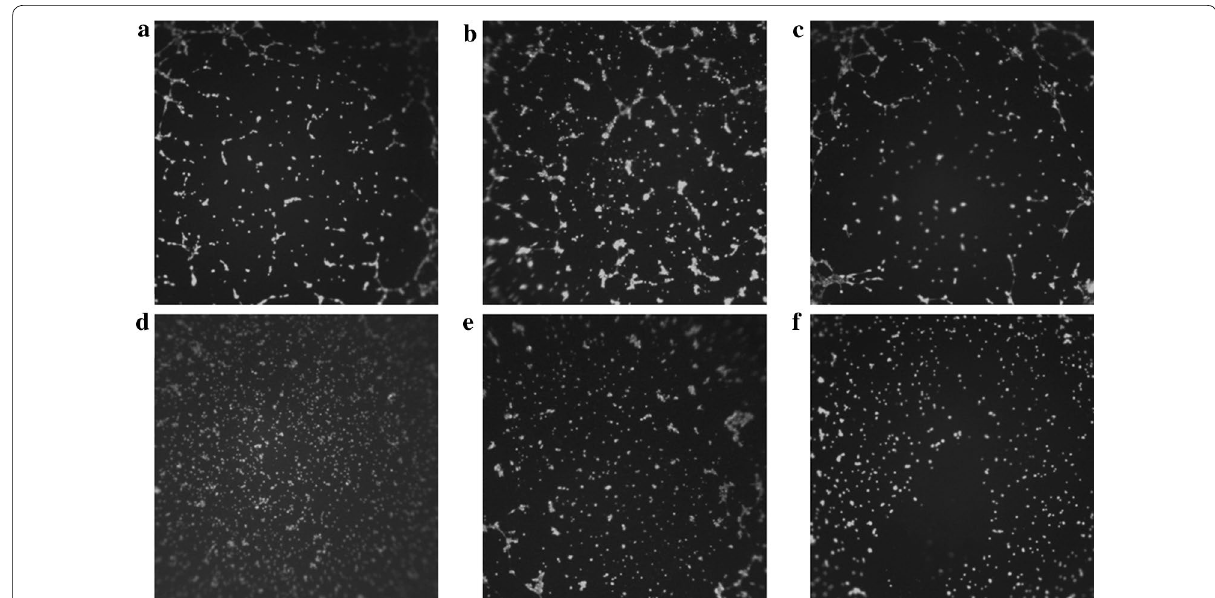
Fig. 5 Compounds 7 , 13 – 15 , and sunitinib inhibited tube formation induced by VEGF. a VEGF (10 ng/ml) and 1.0 μM 15 ; b VEGF (10 ng/ml) and 2.0 μM sunitinib; c VEGF (10 ng/ml) and 2.0 μM 7 ; d VEGF (10 ng/ml) and 2.0 μM 13 ; e VEGF (10 ng/ml) and 2.0 μM 14 ; f VEGF (10 ng/ml) and 2.0 μM 15